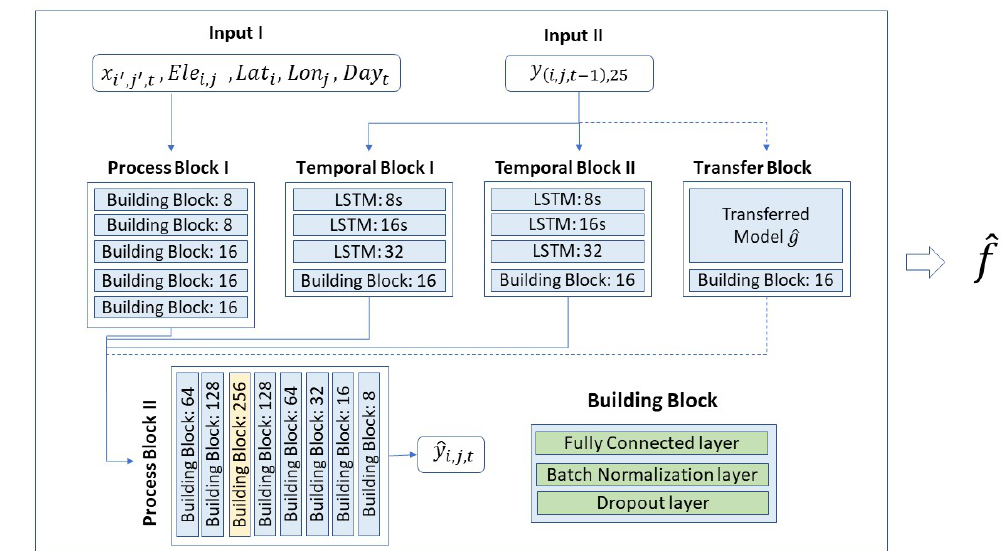
Figure 2. Overall Neural Network structure of ASDM/ASDMTE. The notation LSTM:8s represents a LSTM layer with 8 nodes and return sequence. The notation of Building Block:8 represents a building block with 8 nodes. The light yellow block represents using dropout layer with dropout rate of 0.5. The transfer Block is only used in ASDMTE thus it is connected with dash